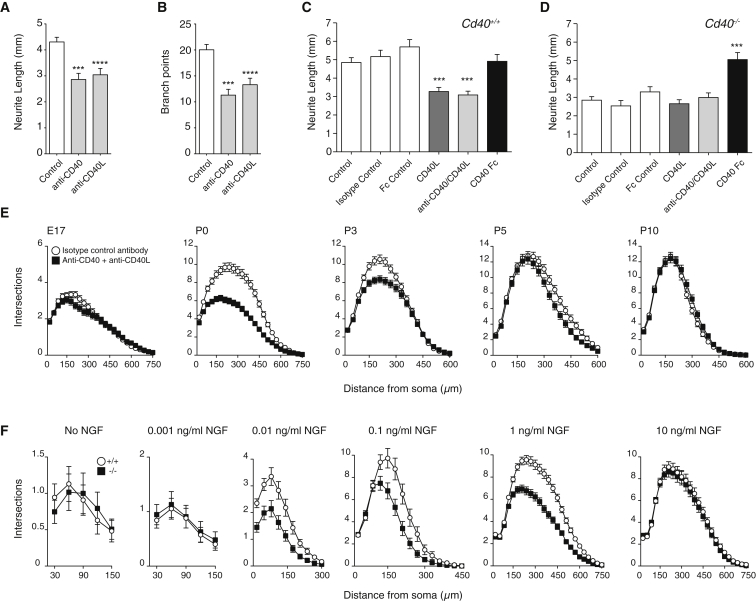
CD40 Signaling Enhances NGF-Promoted Neurite
Growth(A and B) Neurite arbor length (A) and branch point
number (B) of P3 SCG neurons cultured for 24 hr with 1 ng/ml NGF plus
function-blocking anti-CD40, function-blocking anti-CD40L, or isotype control
antibodies (2 μg/ml).(C) Neurite arbor length of P3 SCG neurons cultured for
24 hr in media supplemented with 1 ng/ml NGF alone (control) or 1 ng/ml NGF plus
isotype control antibodies (Iso control), Fc fragment (Fc control), function-blocking
anti-CD40 and anti-CD40L (FB antibodies), 1 μg/ml CD40L, or 1 μg/ml
CD40-Fc.(D) Neurite arbor length of SCG neurons obtained from P3
Cd40−/− littermates cultured under the
same conditions as in (C). ∗∗∗∗p < 0.0001;
∗∗∗p < 0.001, ANOVA with Bonferroni
correction, statistical comparison with controls.(E) Sholl plots of neurite arbors of E17–P10 SCG neurons
cultured for 24 hr with 1 ng/ml NGF plus either function blocking or isotype control
antibodies.(F) Sholl plots of the neurite arbors of P3 SCG neurons
of Cd40+/+ and
Cd40−/− littermates grown for 24 hr with a
concentration range of NGF and 25 μM Boc-D-FMK to prevent apoptosis at low NGF
concentrations. Mean ± SEM data of >150 neurons per condition combined from three to
five experiments of each type.